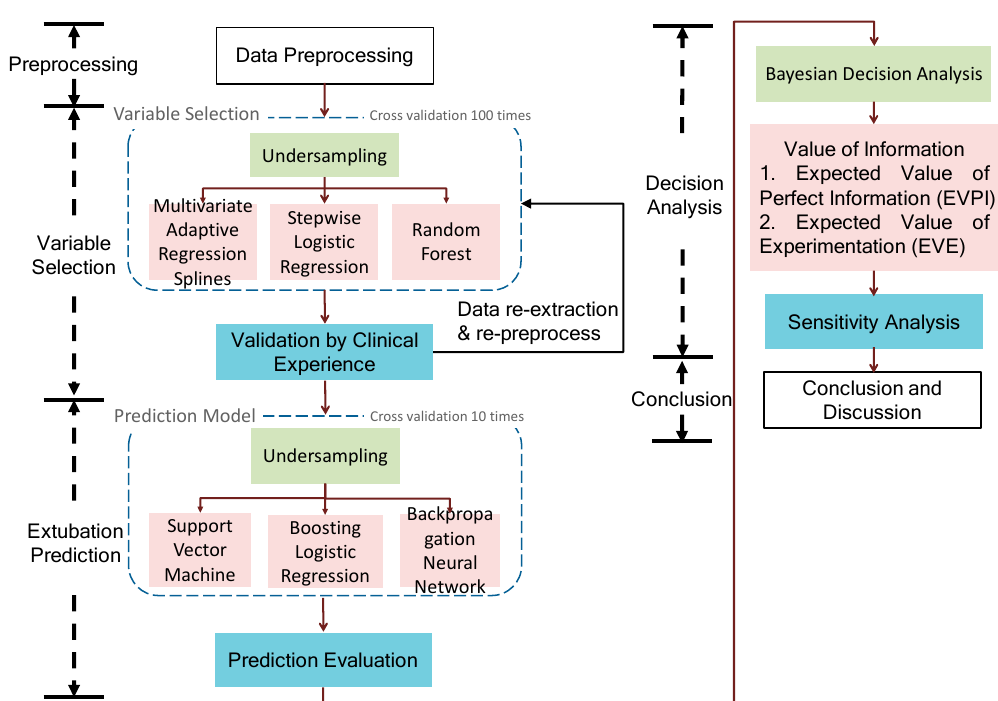
Figure 1. The data science framework of endotracheal extubation.